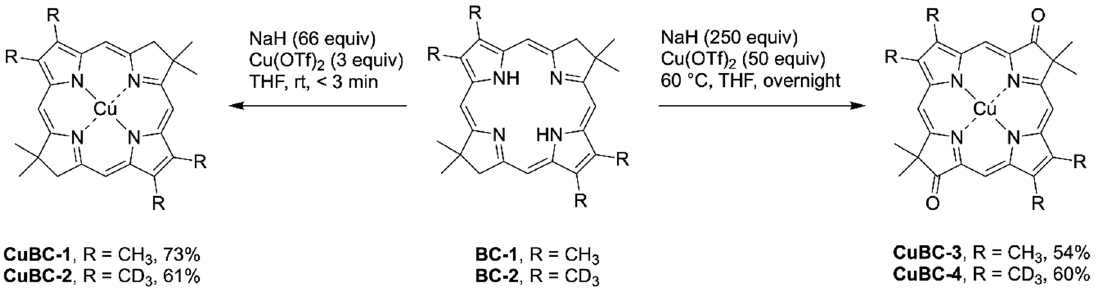
Scheme 3. Copper insertion of BC-1 and BC-2